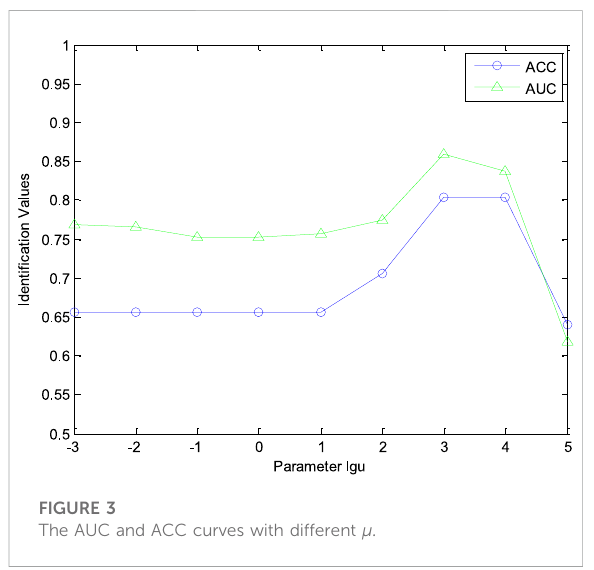
FIGURE 3 The AUC and ACC curves with different μ .